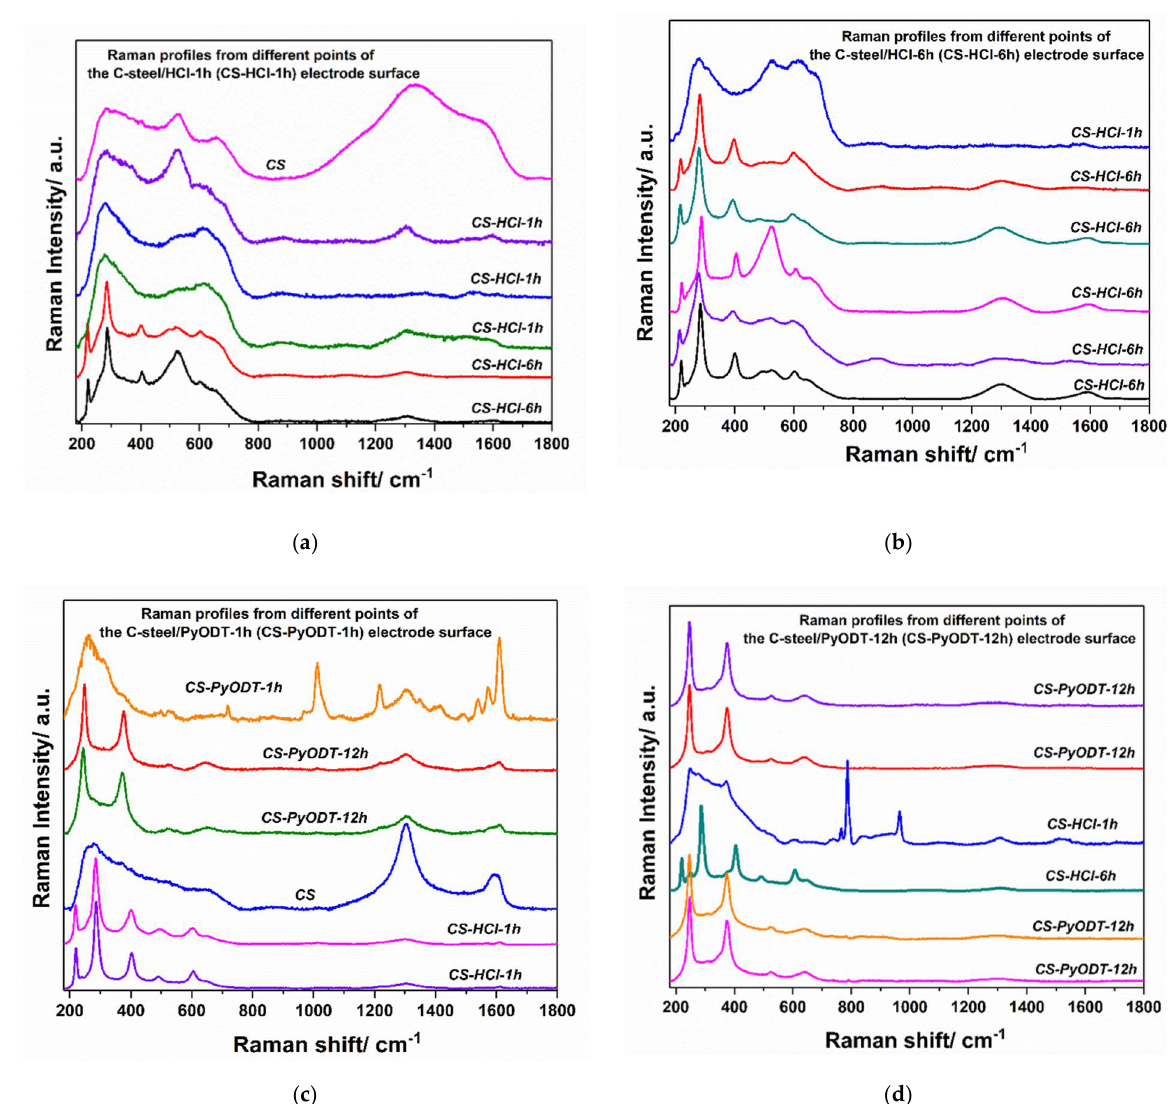
Figure 14. Raman spectra of different points from the C-steel surface after various treatments: 1 h immersion in 1.0 M HCl ( a ); 6 h immersion in 1.0 M HCl ( b ); 1 h immersion in 5 mM PyODT-containing solution ( c ); 12 h immersion in 5 mM PyODT-containing solution ( d ). The italic notation from each spectrum indicates the prediction obtained after evaluating the best-performing model (KNN) on the testing dataset.